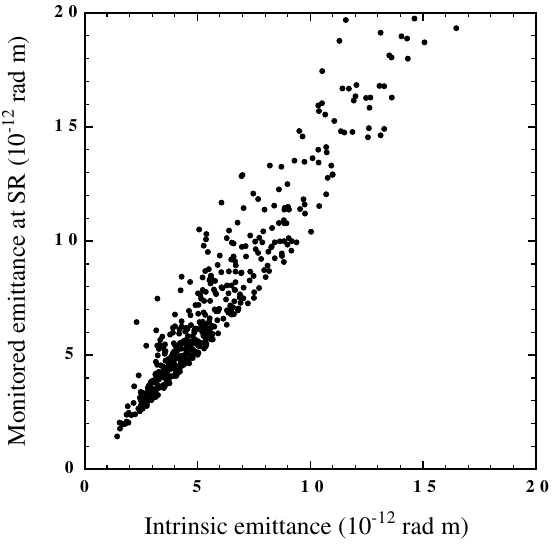
at the SR monitor vs (cid:26) y; mon